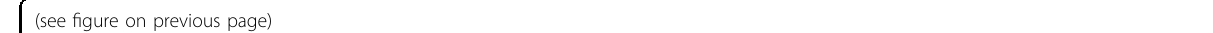
Fig. 2 NUPR1 mediates autophagic survival and NUPR1 depletion induces premature senescence. A Immunoblots of LC3B and SQSTM1 were carried out in MCF-7 and T-47D cells treated with 0.4µM Tam for the indicated time; ACTB served as a loading control ( n = 3). B MCF-7TamR cells were transfected with NUPR1 shRNA and treated with 0.4µM Tam. Immunoblots of NUPR1, LC3B, and SQSTM1 were performed as described in A . C Cellular viability was assessed in NUPR1 -shRNA MCF-7TamR and T-47DTamR cells treated with Tam for 48h as well as in the parental control cells. Experiments in C were replicated twice, yielding similar results. ** P < 0.01, compared to the shRNA control cells. D Immunoblot of NUPR1 in MCF-7TamR cells, MCF- 7TamR cells transfected with NUPR1 cDNA (NM_012385) in an expression vector and their corresponding parental cells; ACTB served as a loading control (left panel). Right panel, cell viability assay as described in C . N.S. not signi fi cant. E Analysis of GFP-mCherry-LC3 fl uorescent signals. MCF-7TamR cells were transfected with GFP-mCherry-LC3 plasmid, and treated with 10µm torin 1 or 50mM trehalose for 10h. White arrows indicate dilated vacuoles. Lower panel, quanti fi cation of the number of GFP or mCherry puncta per cell in NUPR1 -depleted and control cells (ten cells per group). Error bars represent the mean ± SD. F Representative light microscopy images of GLB1 staining in MCF-7TamR and T-47DTamR cells with NUPR1 and/or ATG7 shRNA following the indicated treatment for 10h. Lower panel, quanti fi cation of the dilated vacuoles from three independent experiments (mean ± SD, n = 10). Right panel, immunoblots con fi rmed the knockdown ef fi ciency of shRNAs against human NUPR1 and/or ATG7 , with fi re fl y luciferase as a negative control (con) and ACTB as an internal control. ** P < 0.01, compared to the shRNA control